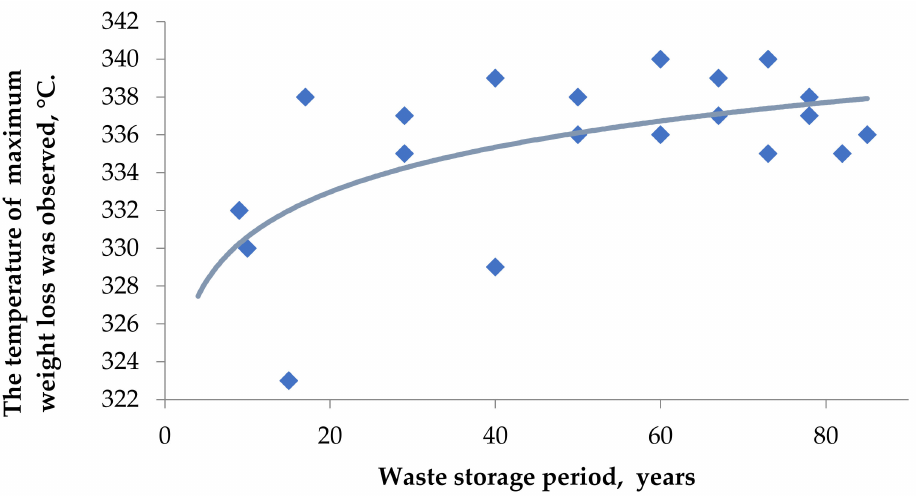
Figure 5. Change in the samples’ thermal